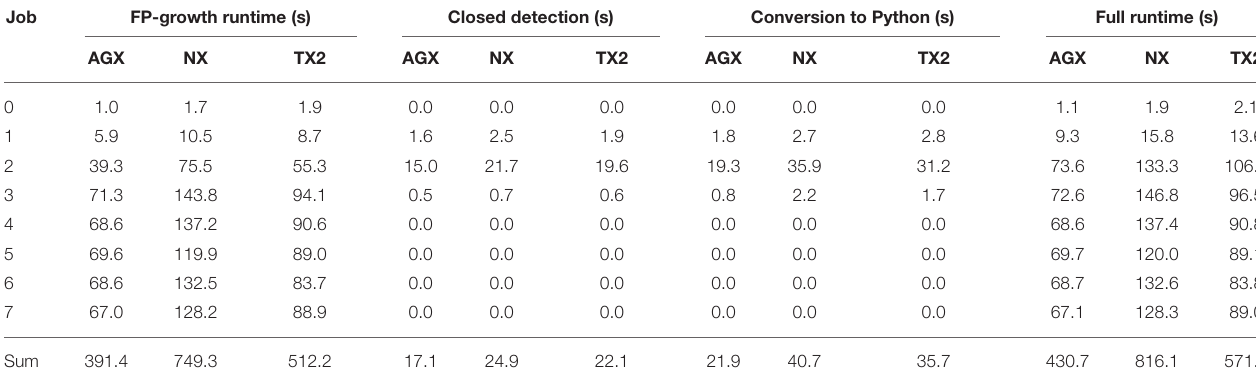
TABLE 5 | Runtime of the multi-threaded implementation on all three embedded devices.